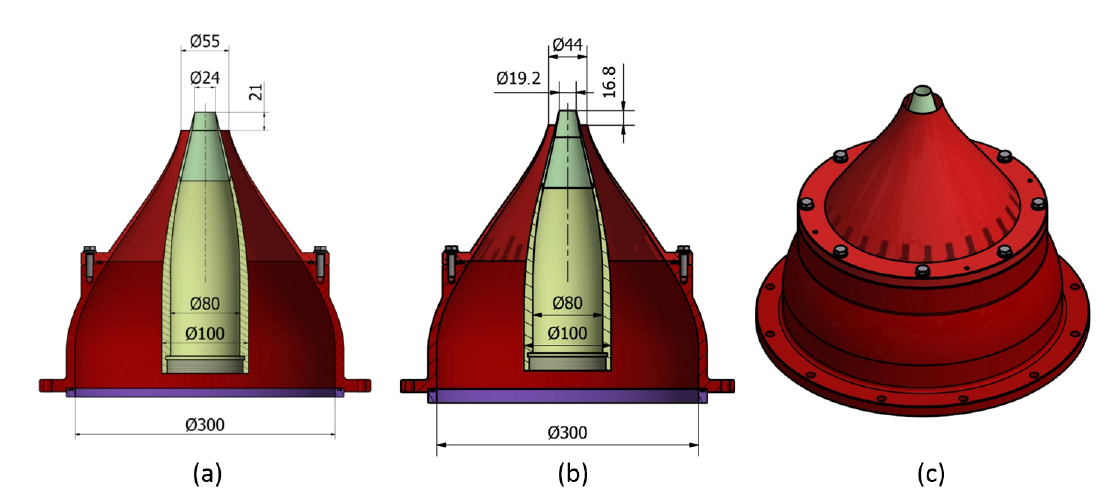
Figure 4. CAD drawing of the coaxial nozzles sets. Dimensions are in mm. ( a ) Nozzle Set 1, used for CFD and single stream jet experiments; ( b ) Nozzle Set 2, used for single and dual stream experiments; ( c ) 3D view.